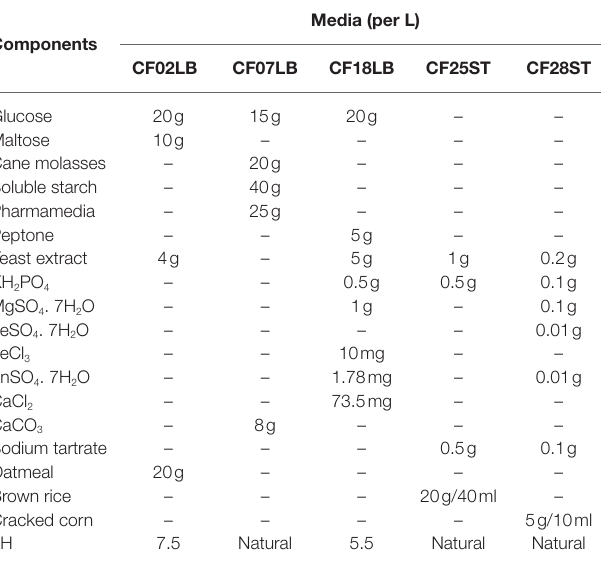
TABLE 1 | Composition of the five media used in the study.